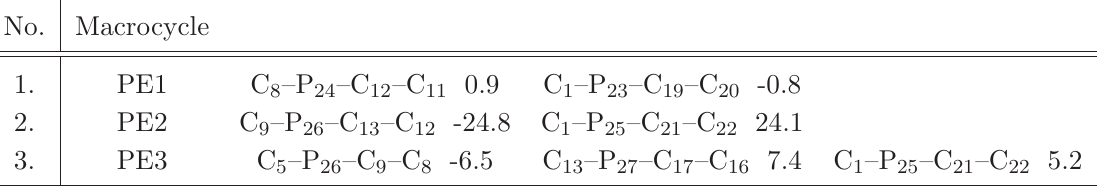
Table 5 Endocyclic torsion angle C-P-C-C obtained with PM3 method (deg)